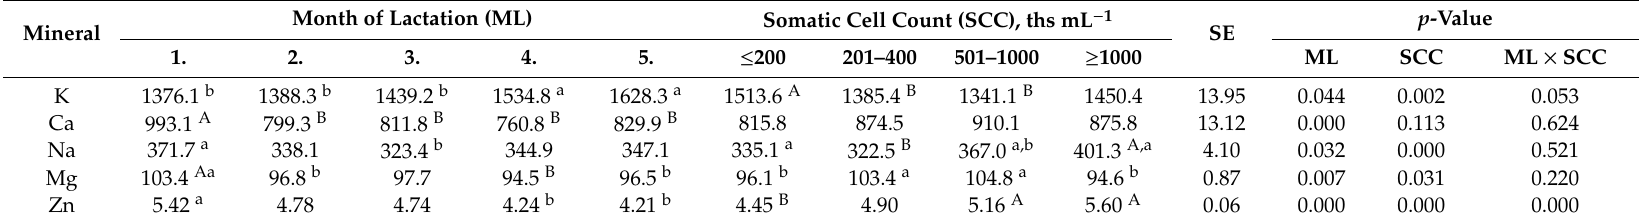
Table 2. E ff ects of the month of lactation and the udder health of cows on the content of potassium (K), calcium (Ca), sodium (Na), magnesium (Mg) and zinc (Zn) in milk, mg dm − 3